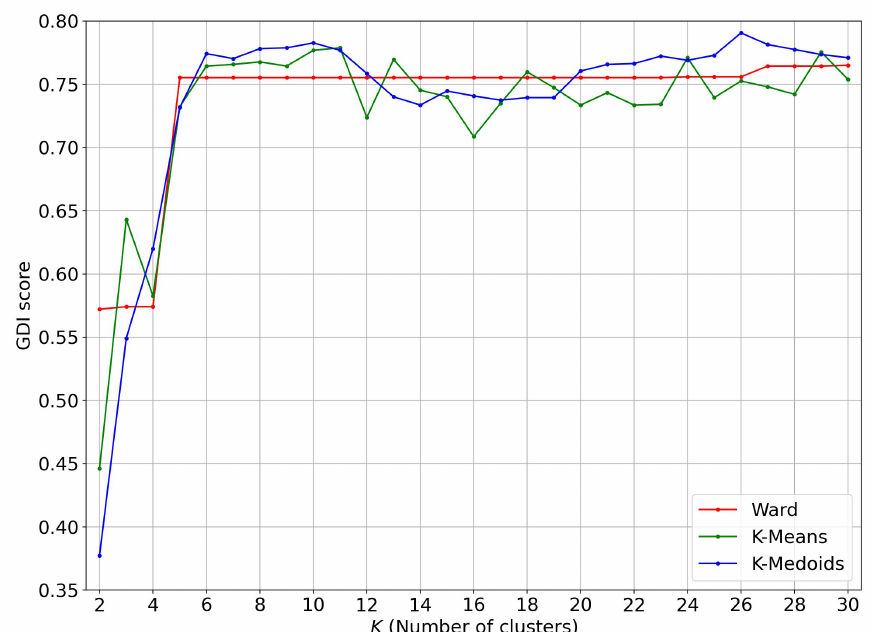
Figure 14. GDI score evolution of various clustering algorithms on the persistence